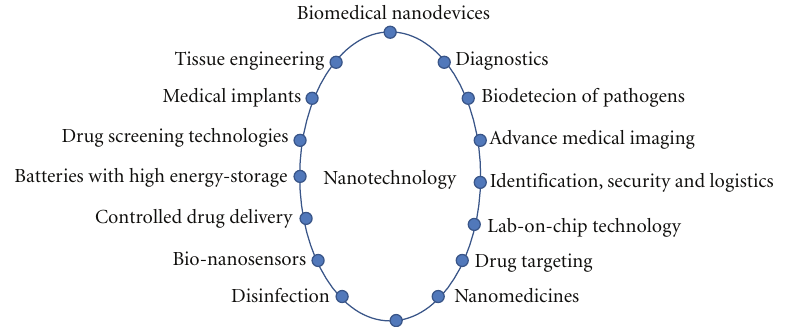
Figure 1: Schematic illustration of nanotechnology revolutionizing biomedical